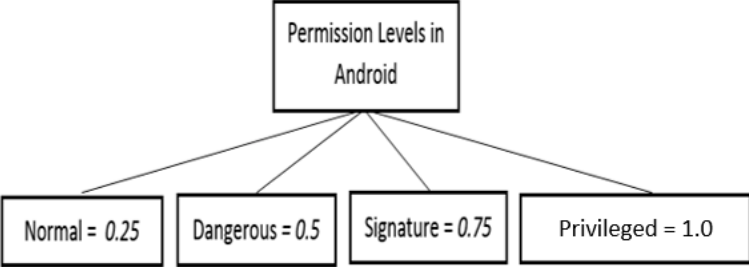
Figure 1. Classification of permission levels and their assigned value.